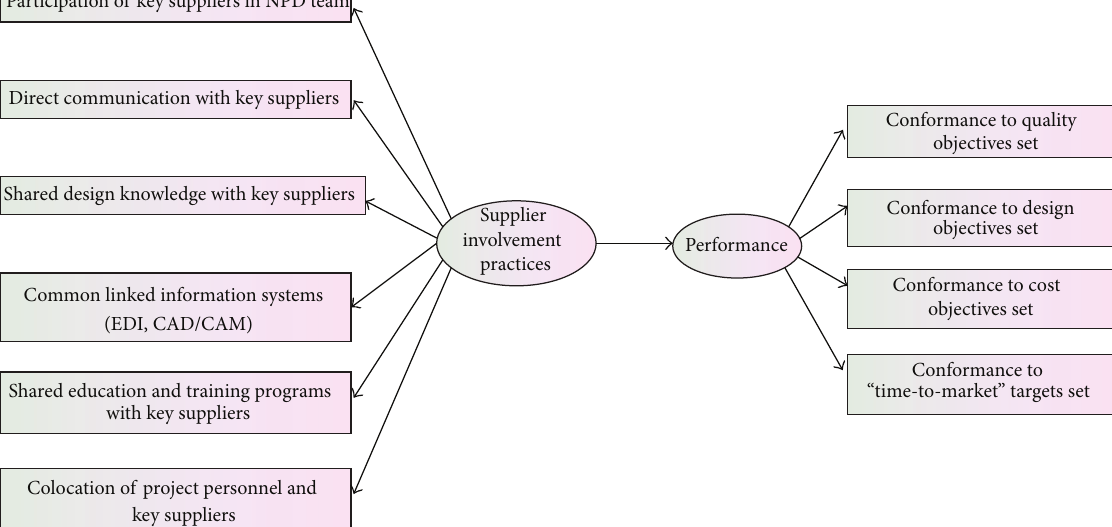
Figure 1: Shows the conceptual framework of supplier involvement